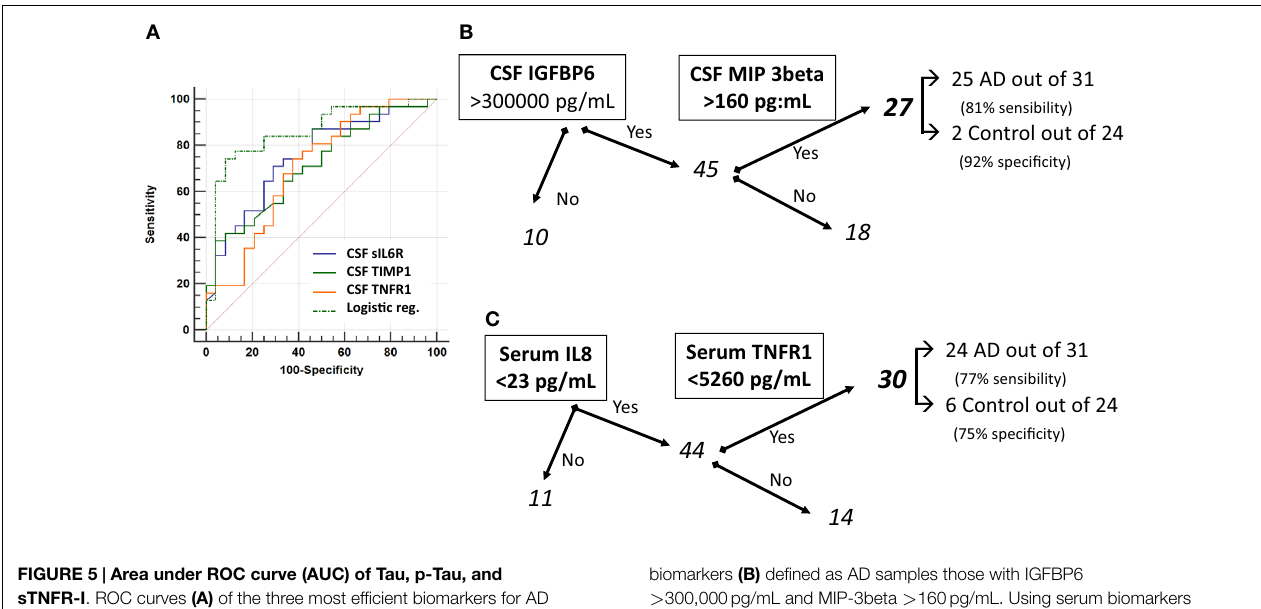
FIGURE 5 | Area under ROC curve (AUC) of Tau, p-Tau, and sTNFR-I . ROC curves (A) of the three most efficient biomarkers for AD diagnosis sIL-6R, TIMP-1, and sTNFR-I were plotted along with their combination (logistic regression, see text). The classification tree for CSF